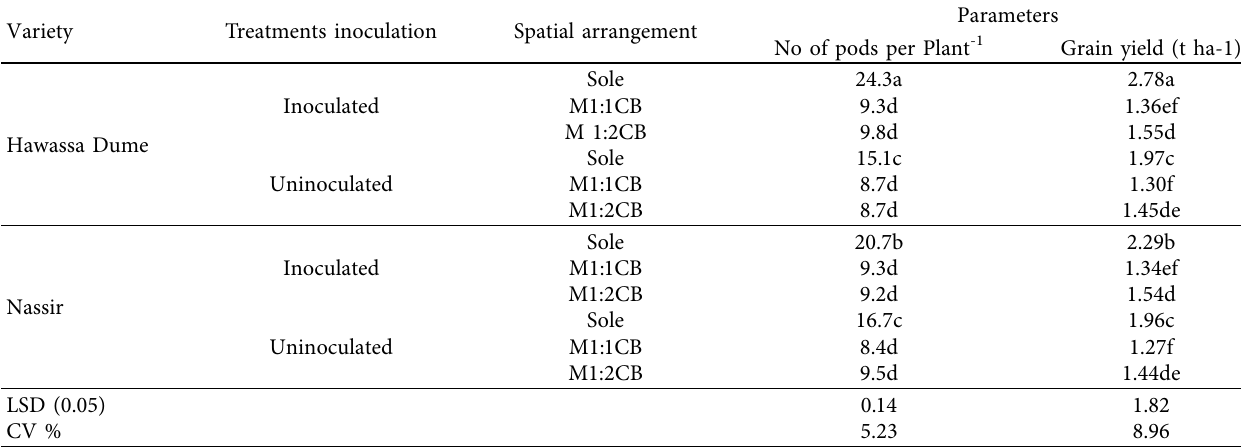
Table 9: Interaction efects of variety x inoculation x spatial arrangement on yield component of common bean.